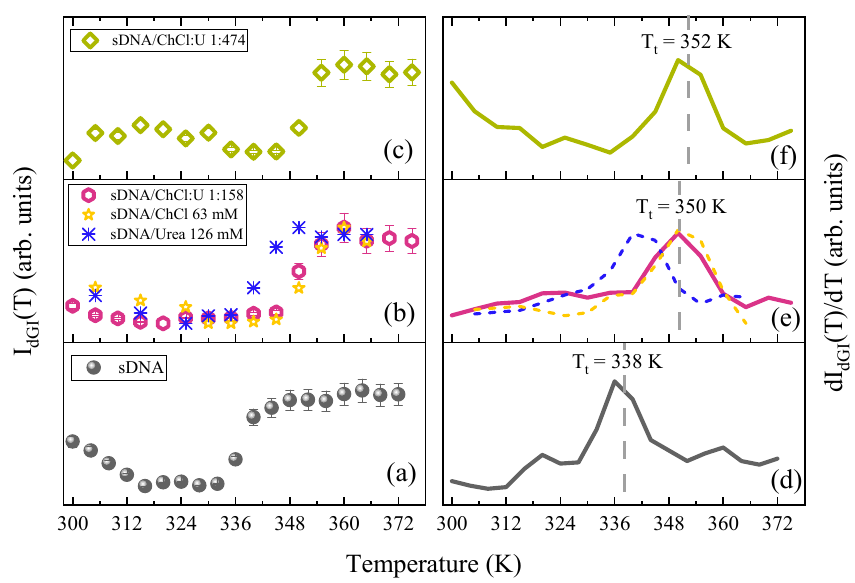
Figure 3. ( a – c ) Temperature dependence of the Raman intensity of the dGI band for sDNA and sDNA/ChCl:U (1:158 and 1:474); panel ( b ) shows also the temperature profiles of the dGI band obtained for sDNA in hydrated ChCl (63 mM in Tris) and in hydrated urea (126 mM in Tris). ( d – f ) First-derivative curves of the temperature profiles ( a – c ); the transition temperatures 𝑇 𝑡 obtained for sDNA without and with DES are marked in the corresponding panels.